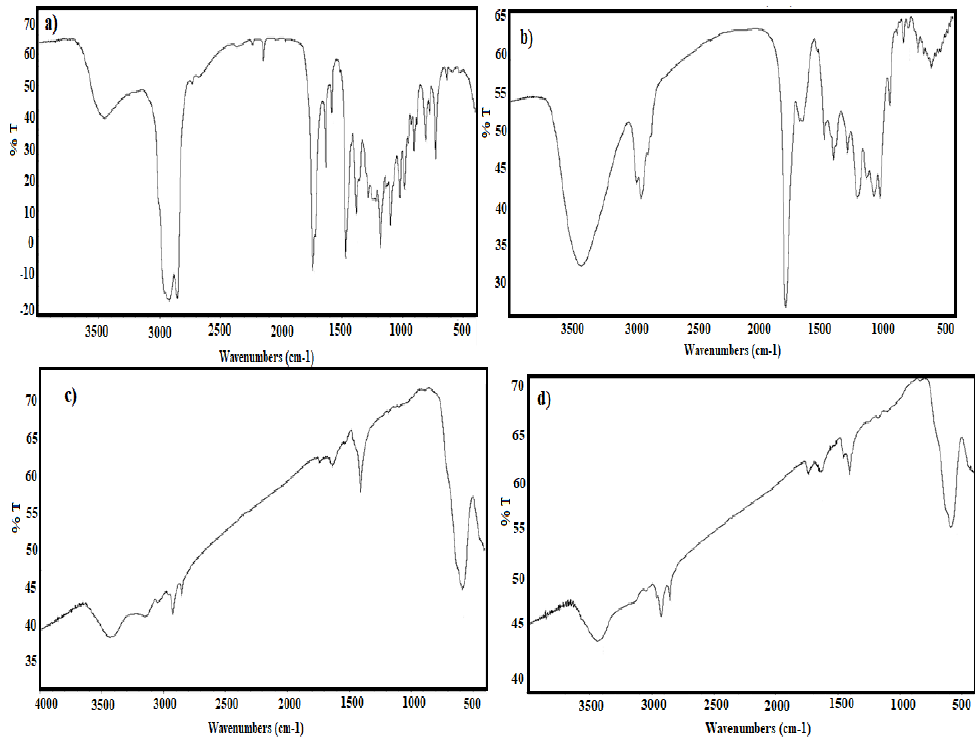
Figure 1. FTIR spectra of ( a ) M. aurea extract (MAE), ( b ) O. baccatus extract (OBE), ( c ) magnetite